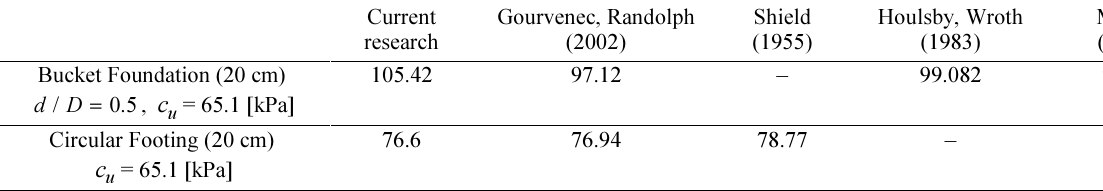
Table 11. Comparison to published data